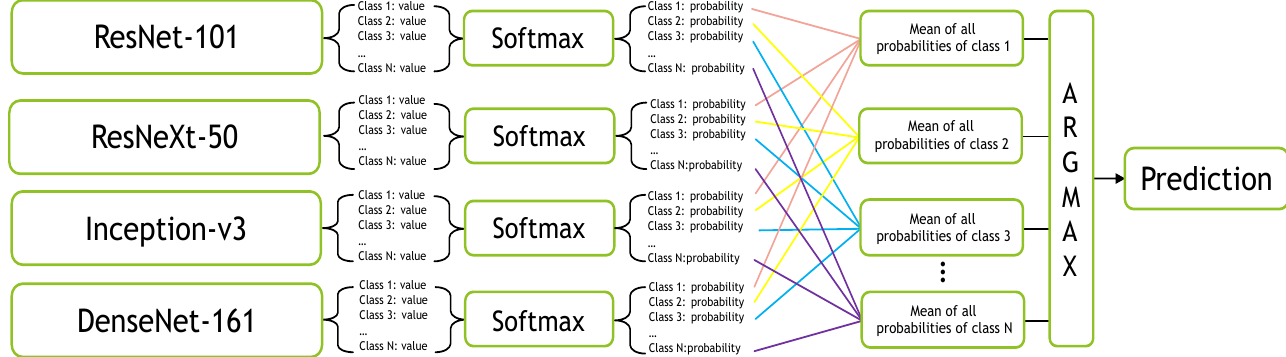
Figure 12. The proposed Mean-Ensemble-CNN